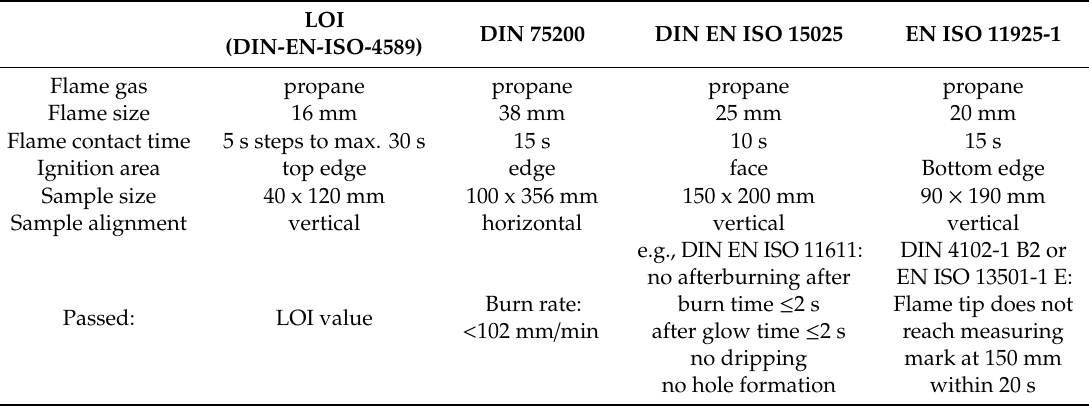
Table 3. Comparison of the test conditions and the passing